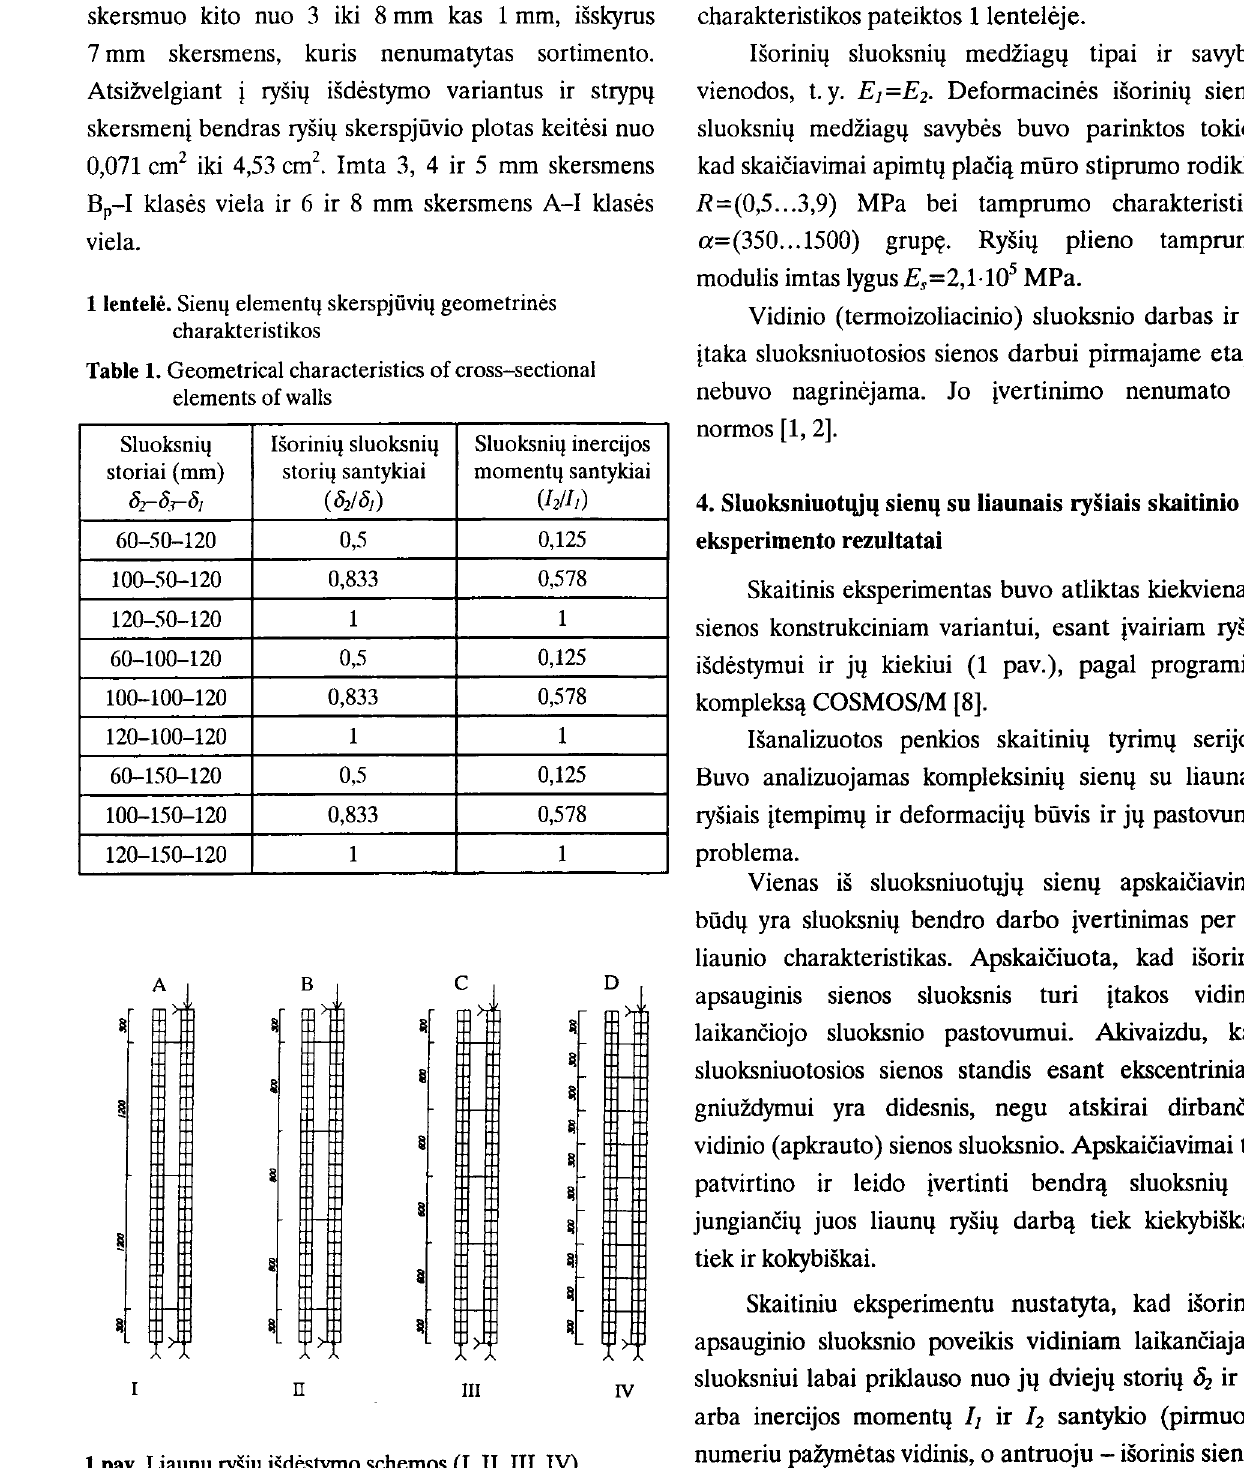
Fig 1. Diagrams (1, II, III, IV) of situation of flexible ties Sienos skaiciuojamosios schemos pavaizduotos 1 paveiksle. Sienos aukStis h=3,0 m, o plotis b=1,0 m. Atstumas tarp sienq sluoksniq centriniq